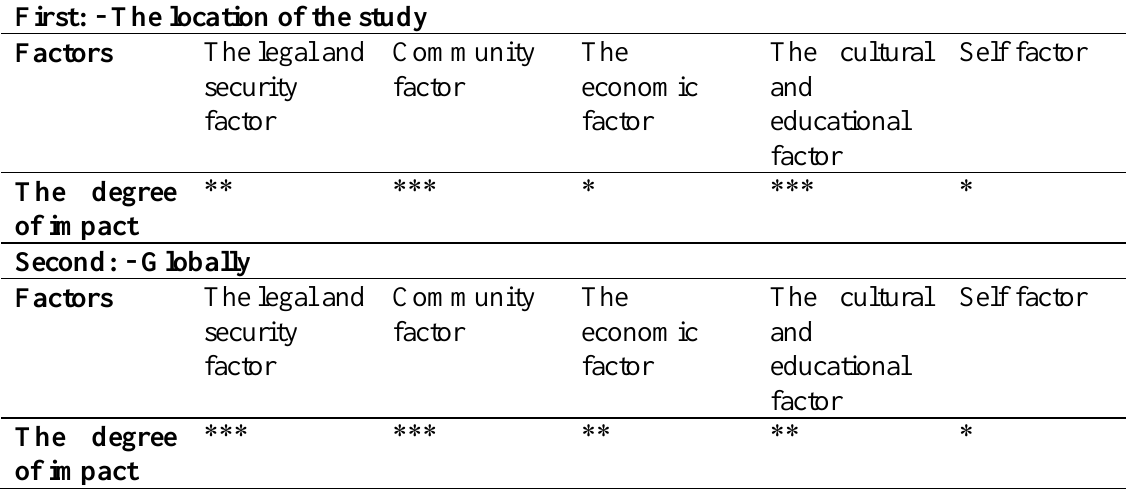
Table 11. Comparison between the impact of broken windows theory experiments globally and on the study site / source: the